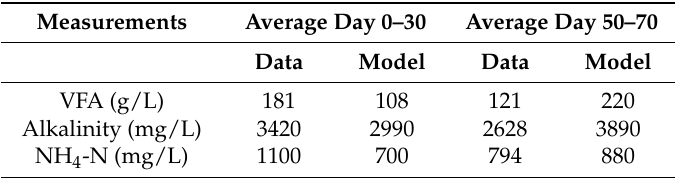
Table 3. Analysis of effluent biosolids from reactor